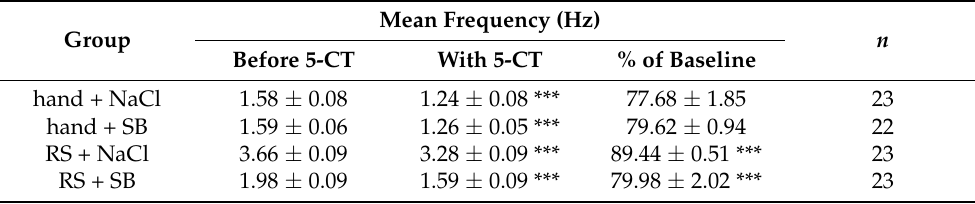
Table 7. Effects of 5-HT 7 receptor activation on parameters characterizing sEPSCs in DRN neurons from rats receiving restraint and SB 269970 (mean ±